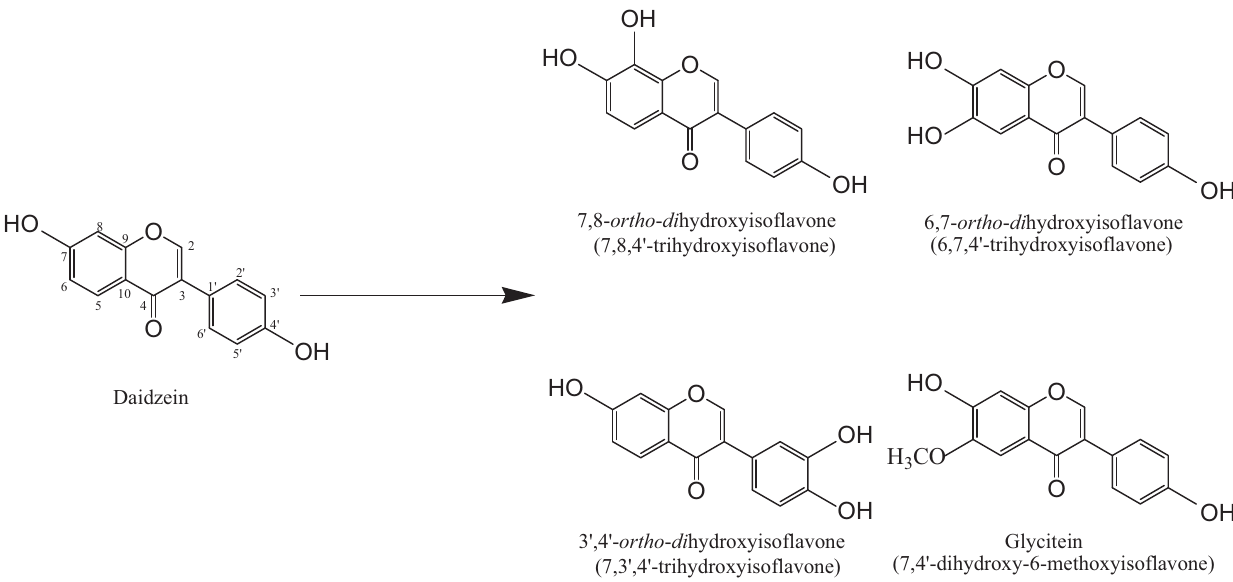
Figure 1. Chemical structures for biotransformation of